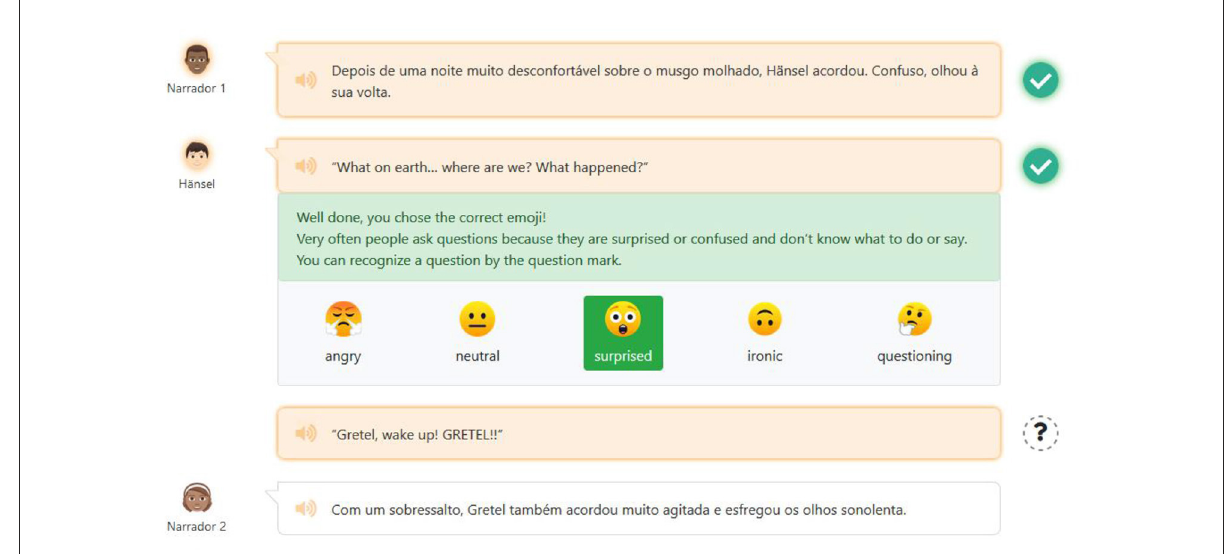
FIGURE6 In the Emoji Tales activity, students practise recognising and understanding emotions in their podcast text. To do this, they first read a passage of text, listen to the corresponding audio model and try to identify the correct emotion by selecting an emoji image.